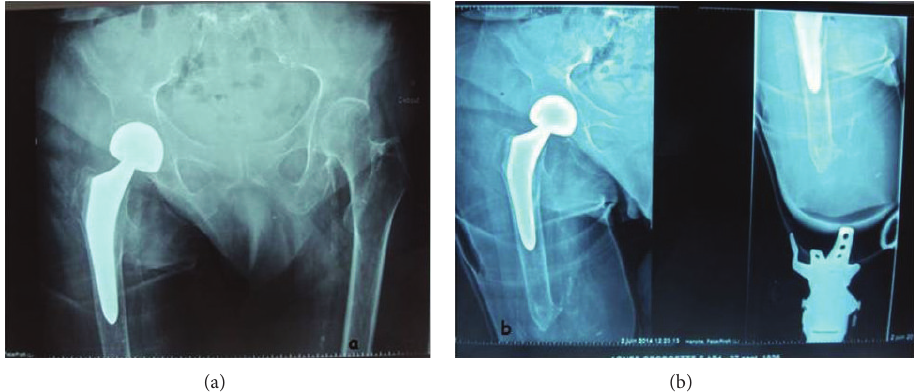
Figure 7: Pelvis and hip radiographies (an anteroposterior X-ray), at the follow-up of 24 months after the